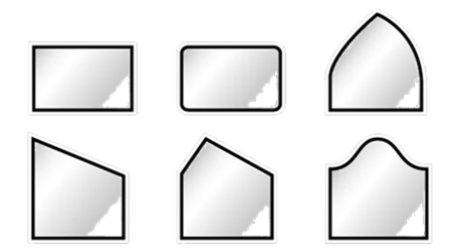
Fig. 6 Examples for realizable planar glass